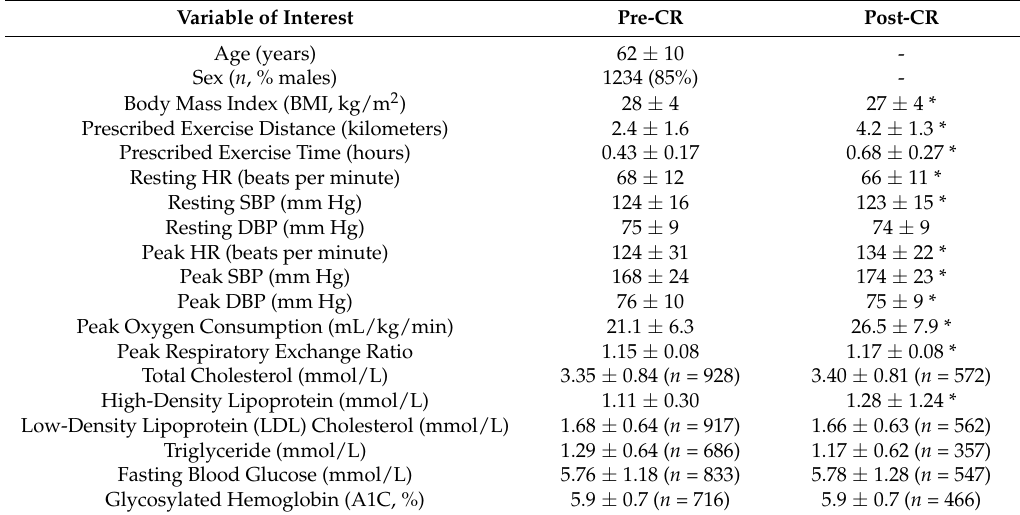
Table 1. Patient demographics and cardiorespiratory fitness assessment results at baseline